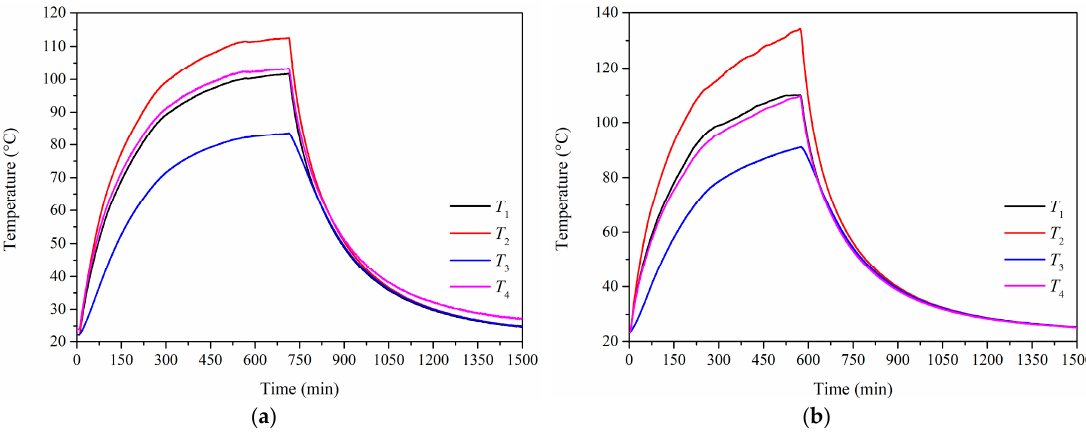
Figure 6. Experimental temperatures for the ( a ) linear load condition and ( b ) dynamic load condition.